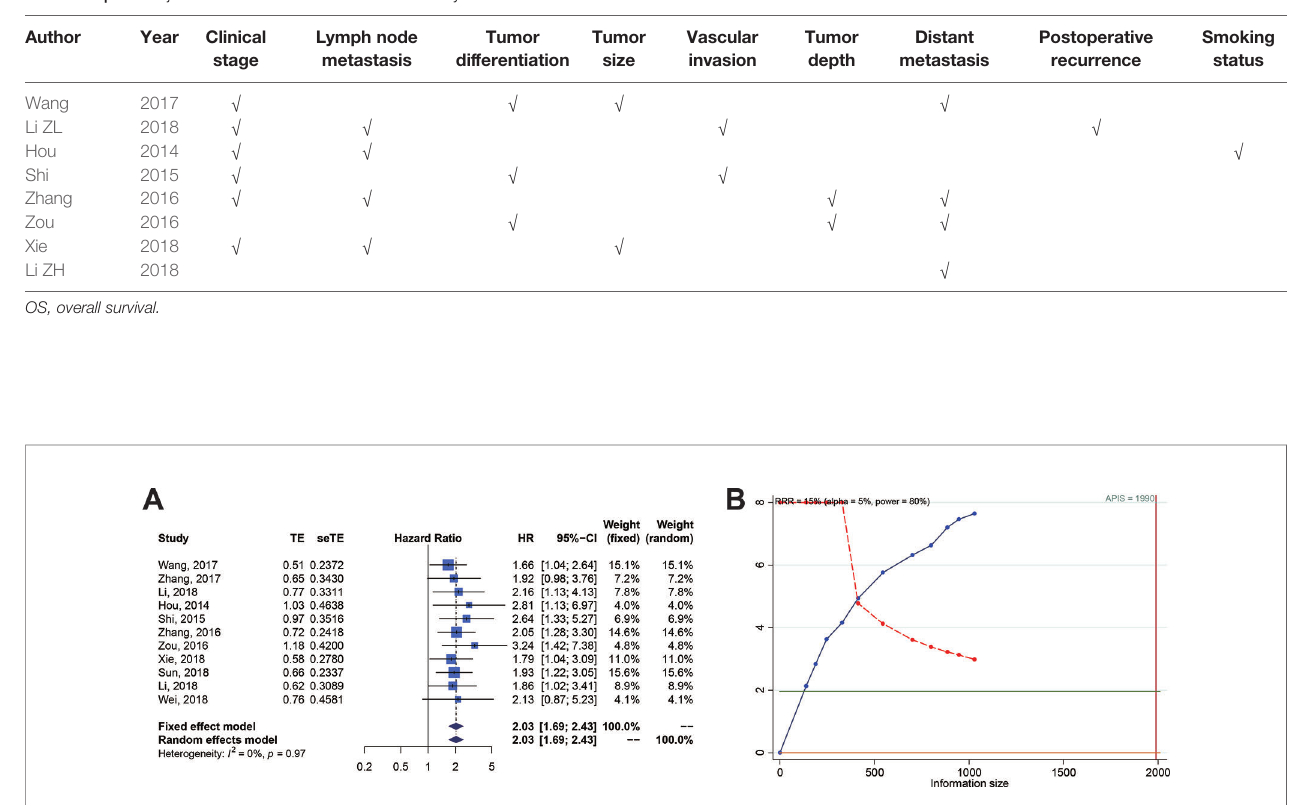
TABLE 2 | The adjusted variables in the multivariate analysis of OS in the 8 included studies.